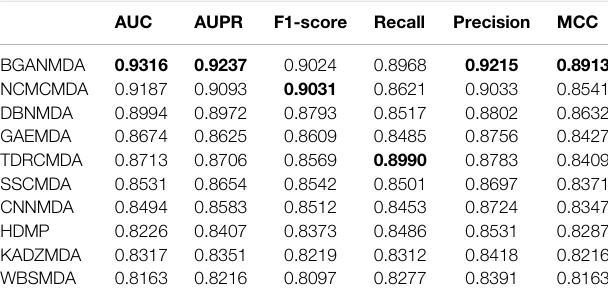
TABLE 1 | TheAUC AUPR, F1-scores, recall, precision,and MCCoftenmethods on miRNA – disease associations prediction task in fi ve-fold cross validation. AUC AUPR F1-score Recall Precision MCC